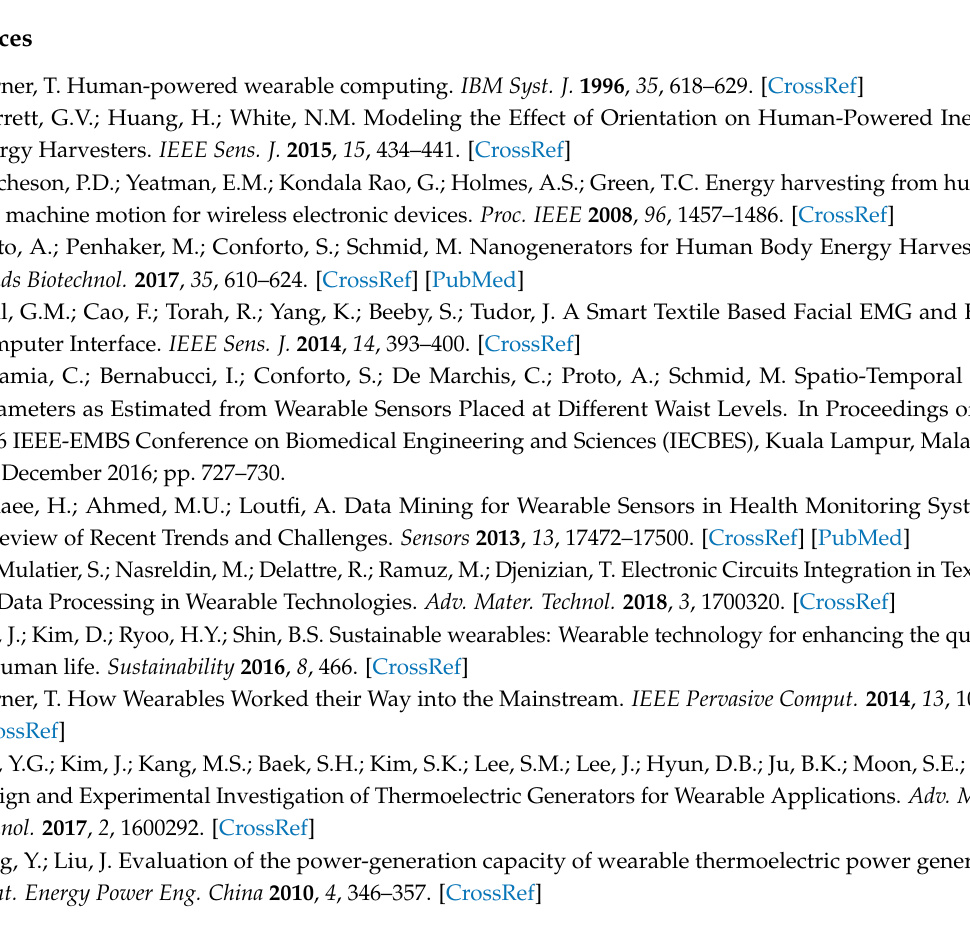
s1. Figure S1: TEG measuring system. Figure S2: NTC 10K3MBD1 thermistor probes on TEG upper side, and multichannel recording system. Figure S3: Chosen materials: gauze and PVC fabrics. Figure S4: Developed band for thermal body energy harvesting. Figure S5: Placement of TEG on upper body parts. Figure S6: Placement of TEG on lower body parts. Figure S7: TEG voltage output when leg remains in a steady position for long time (11,000 s). Figure S8: User riding a bike while wearing the